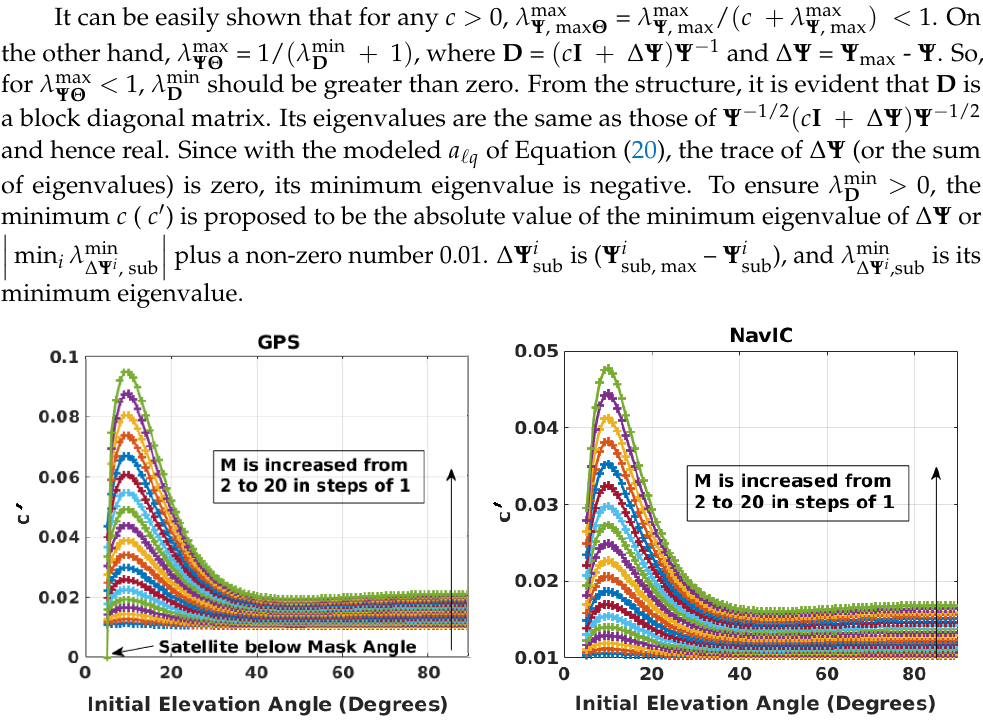
for different values of M and elevation angle (superscript i is removed ( c (cid:48) I + ∆Ψ sub ) Ψ − 1 sub max − c s and ( λ min Ψ , max ) s for each batch and M = min / λ D D